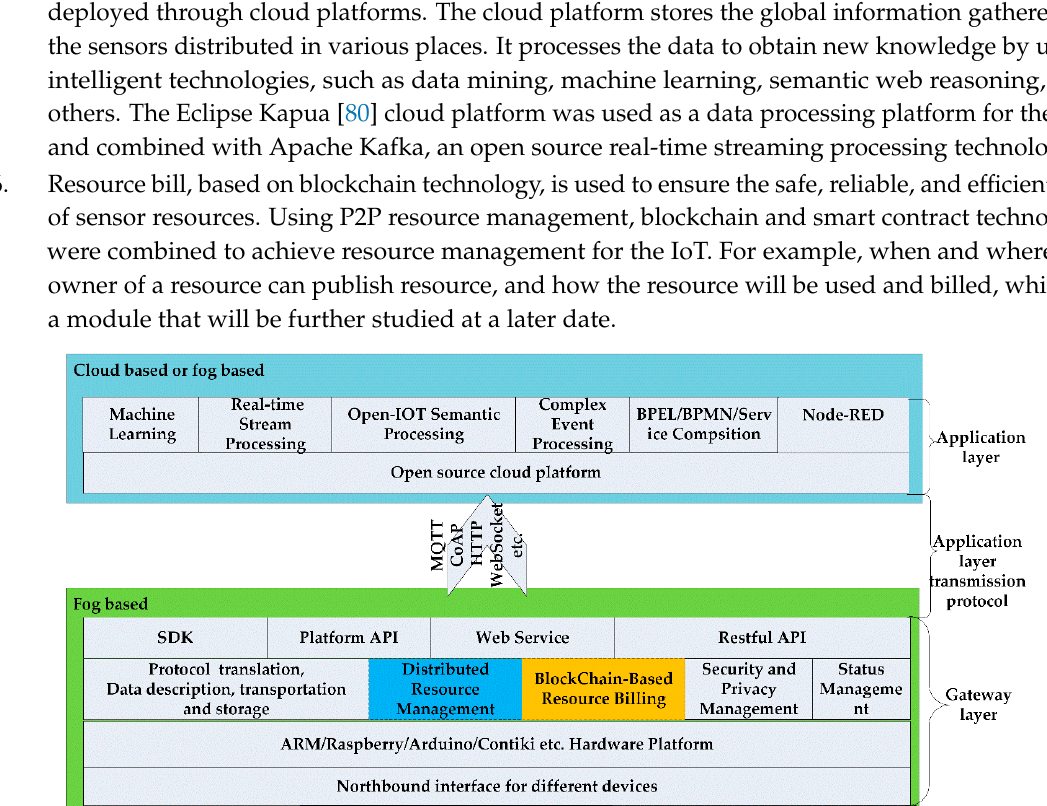
Table 4. Comparison between the IoT requirements and current open source systems.